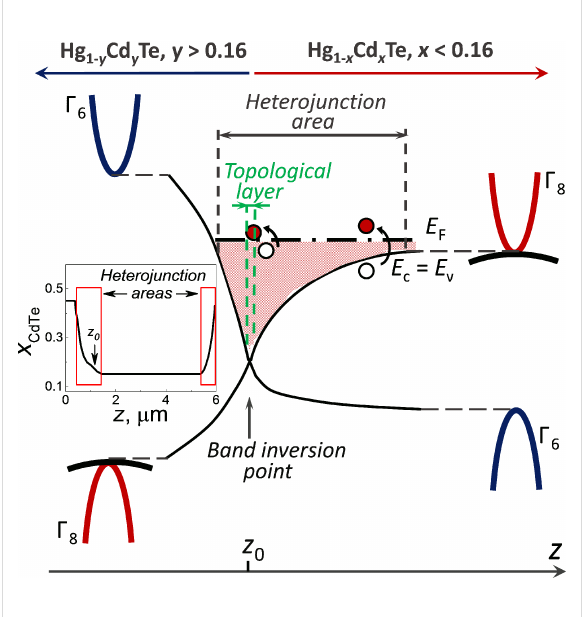
Figure 3: Sketch of the smooth heteroboundary between the Hg 1 − x Cd x Te active layer (with the inverted band structure) and the Hg 1 − y Cd y Te barrier layer (with the normal band structure) in the sam- ples with x < 0.16. Variable position edges of the conduction ( E c ) band, the heavy hole valence ( E v ) subband, and the light hole subband in the heterojunction are schematically shown by black solid lines. The Fermi level is shown by the dash-dot line. The topological layer located in the close vicinity to the z 0 position is sketched up by green dashed lines. The red and the blank circles shown above and below the Fermi level, respectively, correspond to the suggested mechanisms of the positive photoconductivity effect. The CdTe content along the heterostrocture profile is presented in the inset. The red rectangles correspond to the heterojunction areas, the left one of which is zoomed in the main part of the figure.